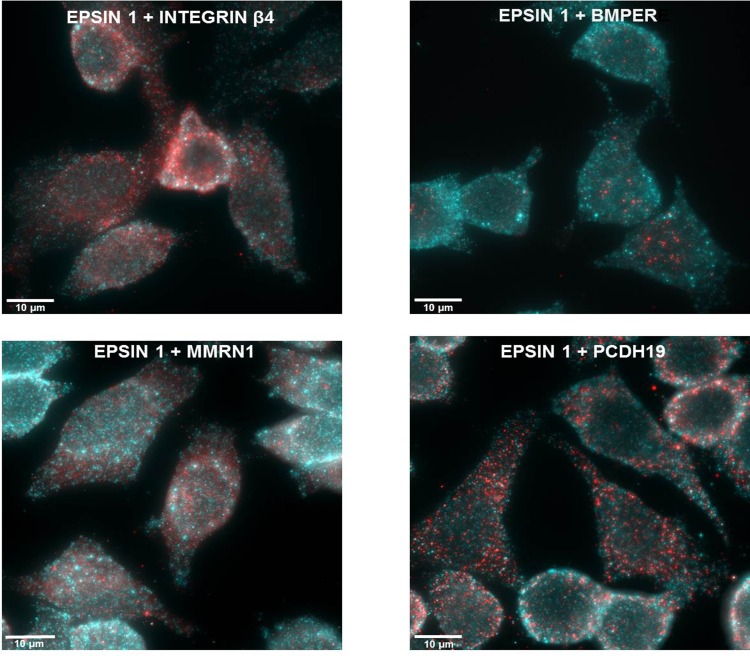
Putative target molecules in A549 cells.A549 cells were fixed with 4% para-formaldehyde and stained with a combination of a mouse anti Eps 1 and one of the following: rabbit anti Int β4, PCDH19, MMRN1, or BMPER. The secondary antibodies used were either Alexa Fluor 405-conjugated AffiniPure Goat Anti-Mouse IgG (blue) or Alexa Fluor 594-conjugated AffiniPure Goat Anti-Rabbit IgG (red) in accordance with the primary antibody used. 3D SIM images were taken using the Elyra SIM imaging system.